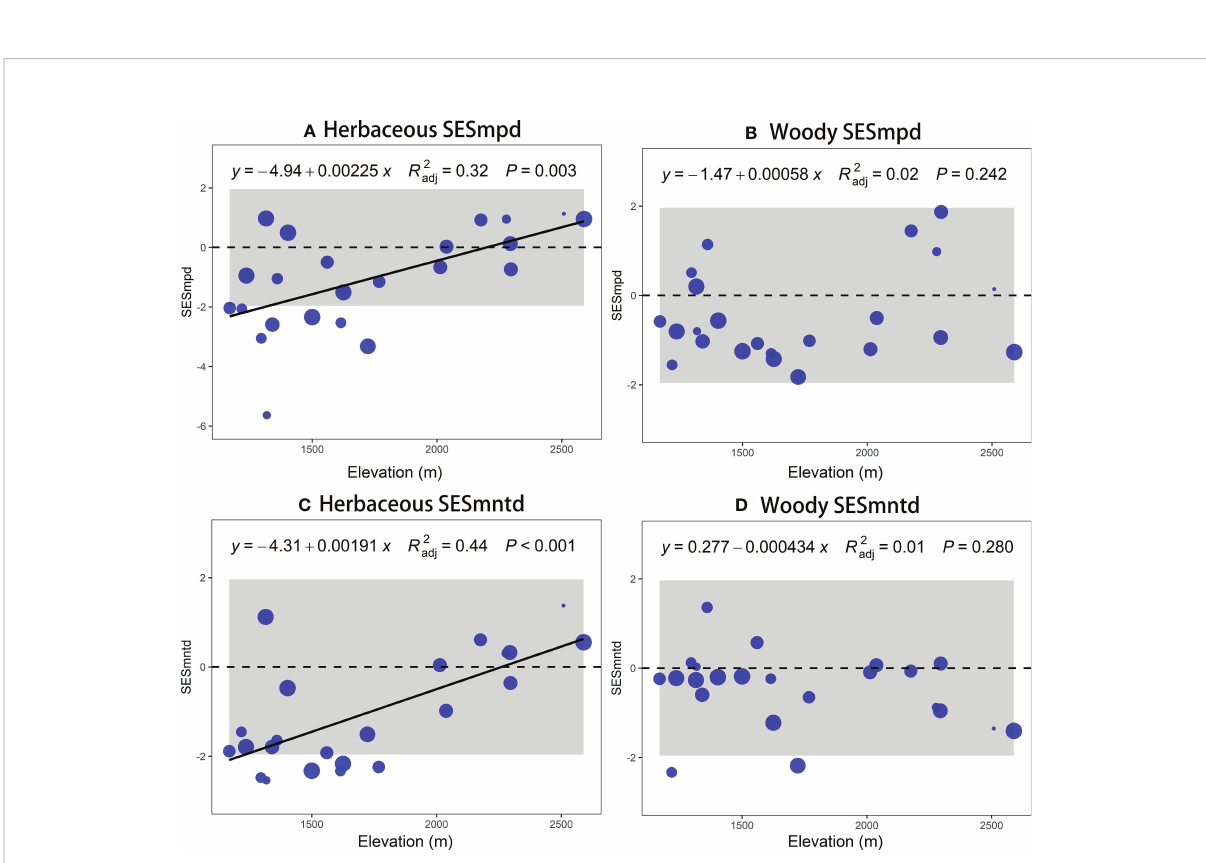
FIGURE 3 Elevational patterns of standardized values of mean phylogenetic structure (SESmpd and SESmntd) of plant communities of herbaceous (A, C) and woody (B, D) . The size of the circle indicates the relative species richness associated with each